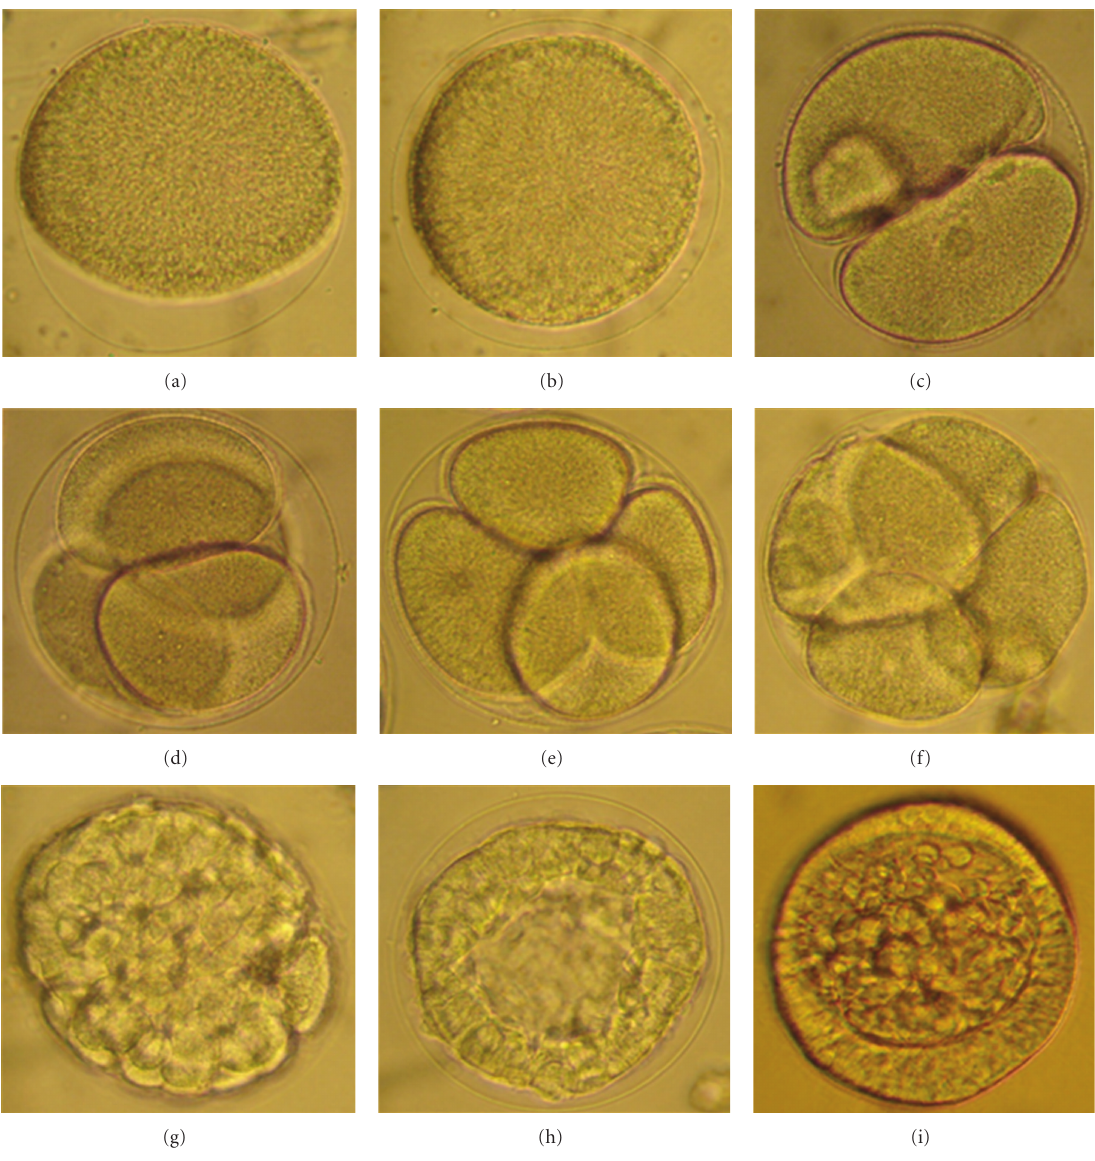
Figure 1: Embryonic developmental stages of S. sphaeroides under compound microscopy. (a) Fertilized egg showing fertilization membrane, (b) Fertilized egg with complete fertilization membrane (c) 2-cell stage, (d) 4-cell stage, (e) 8-cell stage, (f) 16-cell stage, (g) 32-cell stage, (h) Morulla stage enclosed with fertilization membrane, (i) Blastula. Table 2: Larval developmental events of S. sphaeroides . Three replicate fertilization experiments were conducted and for each developmental stage, 10 embryos from each replicate were used for the observation and measurement of